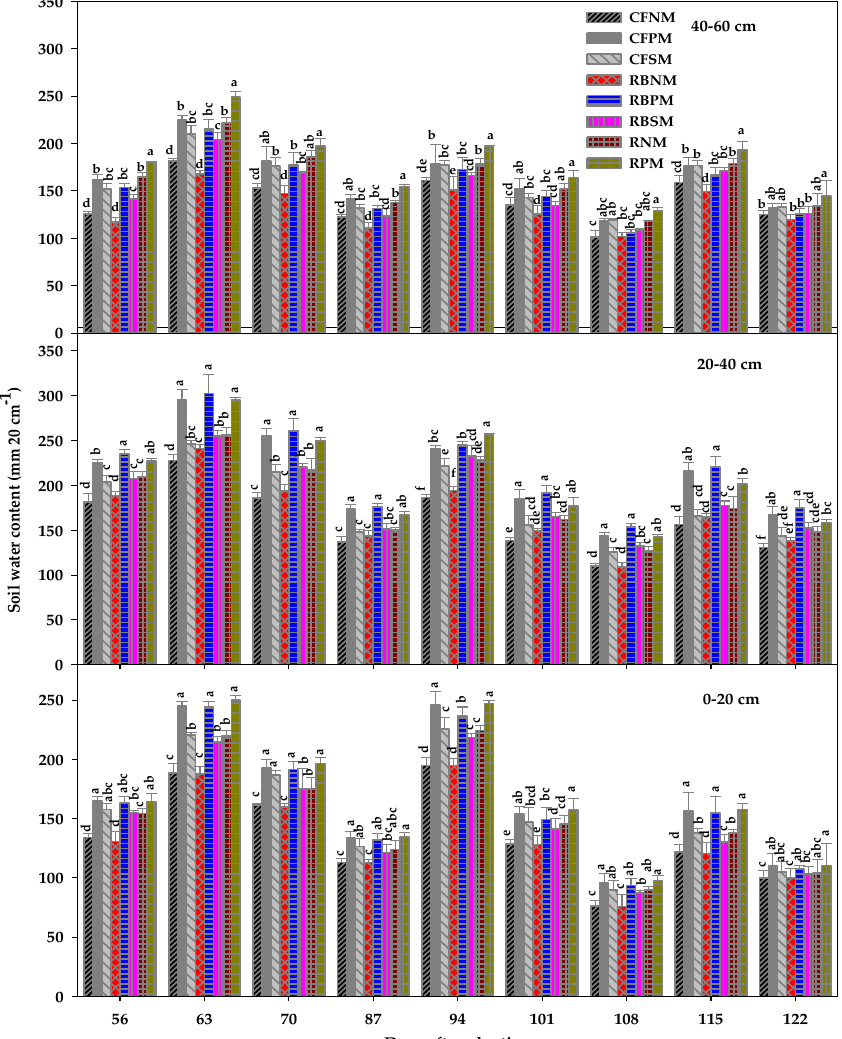
Figure 3. Effects of different planting patterns under limited irrigation rate (0.50 ET) on soil water storage at a 20 cm depth interval within 0 – 60 cm over two growing seasons at different durations (in days) after sowing. Conventional flat planting (CF) without mulching (CFNM); CF with plastic film mulch (CFPM); CF with wheat straw mulch (CFSM); raised-bed planting (RB) without mulch (RBNM); RB with plastic film mulch (RBPM); RB with wheat straw mulch (RBSM); ridge – furrow planting (RF) without mulch (RFNM); and RF with plastic film mulch on both ridges and furrows (RFPM). Bars with different letters are significantly different from each another on the basis of Duncan’s multiple range test at P ≤ 0.05 .